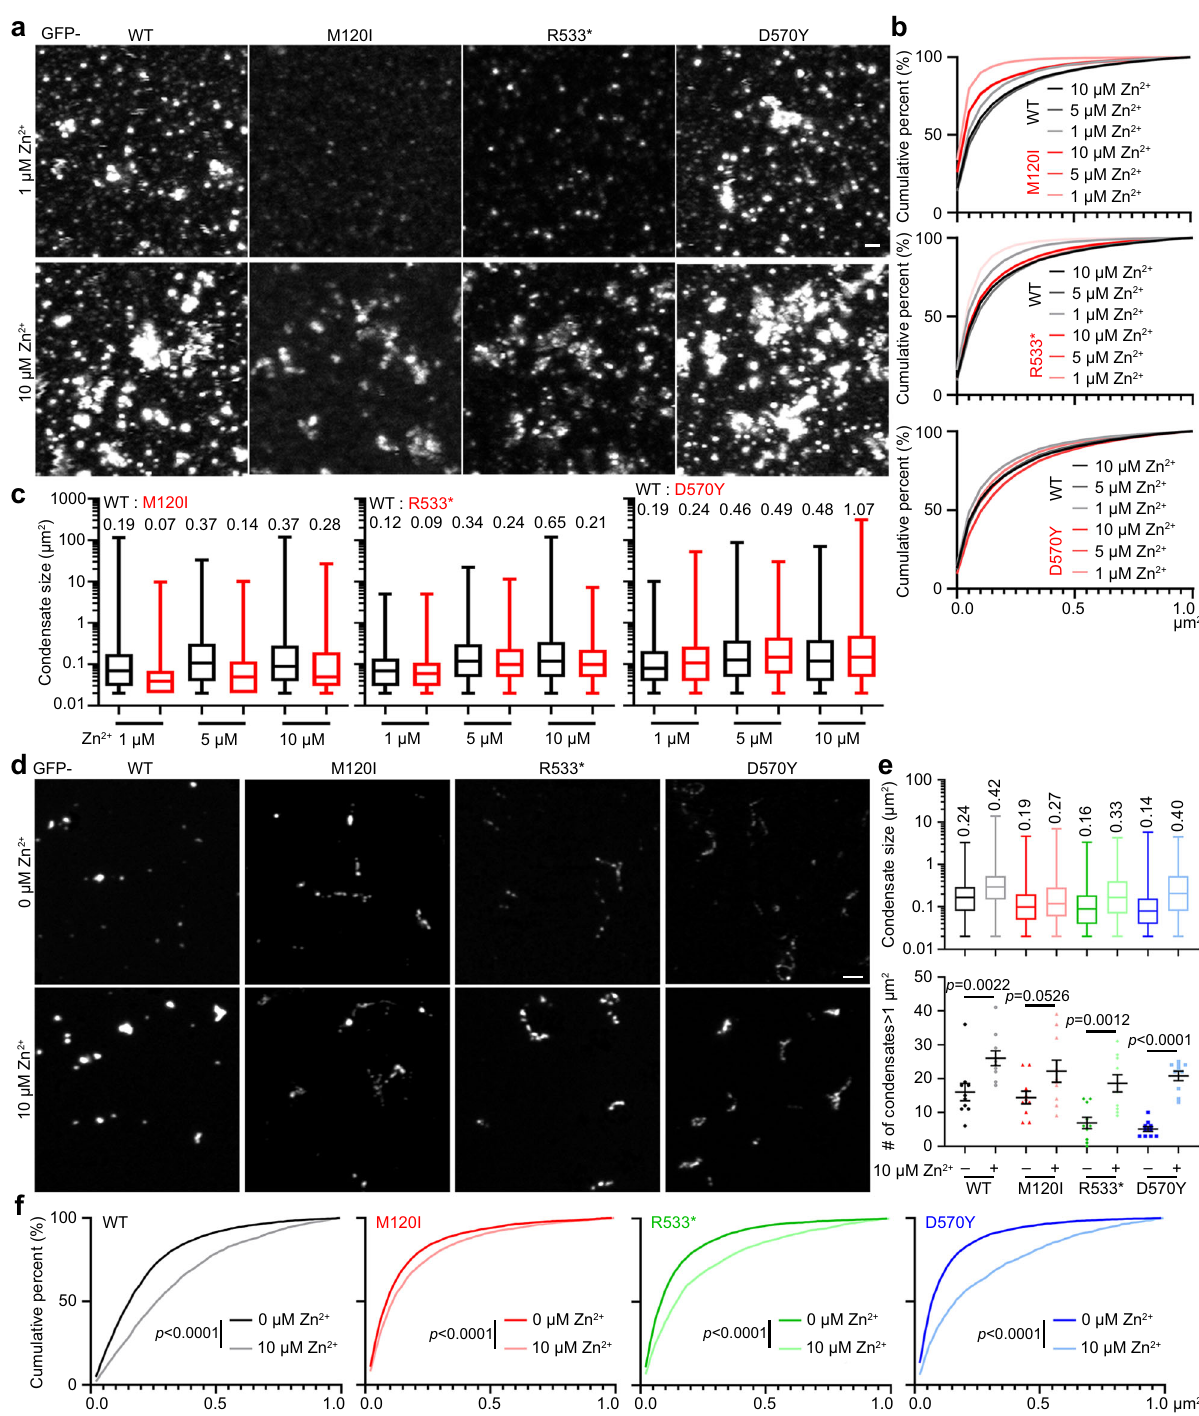
CTTNBP2 forms condensates in neurons . Since CTTNBP2 is a neuron-speci fi c protein, we investigated if CTTNBP2 forms con- densates in neurons and if that represents a critical function for the protein. Cultured hippocampal neurons are a well-established sys- tem for investigating different stages of neuronal development, including axonal and dendritic growth and synaptic formation and maintenance 48 . Using this system, we reported previously that CTTNBP2 forms patches along microtubules at 10 days in vitro (DIV) before dendritic spine formation and that the protein is targeted to dendritic spines when neurons are mature 32 – 34 . Using